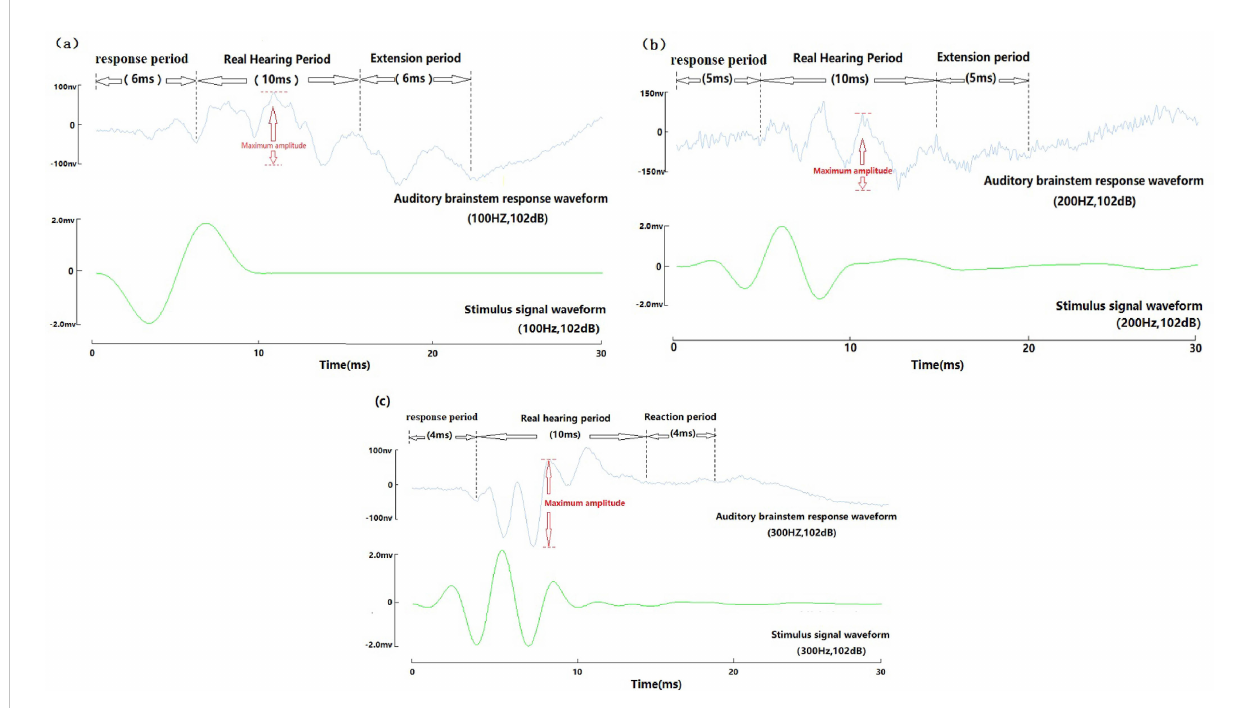
FIGURE 6 Auditory brainstem response three periodic diagrammatic sketch of wild yellow grouper. (A) 100Hz, 102dB three periodic diagrammatic sketch; (B) 200Hz, 102dB three periodic diagrammatic sketch; (C) 300Hz, 102dB three periodic diagrammatic